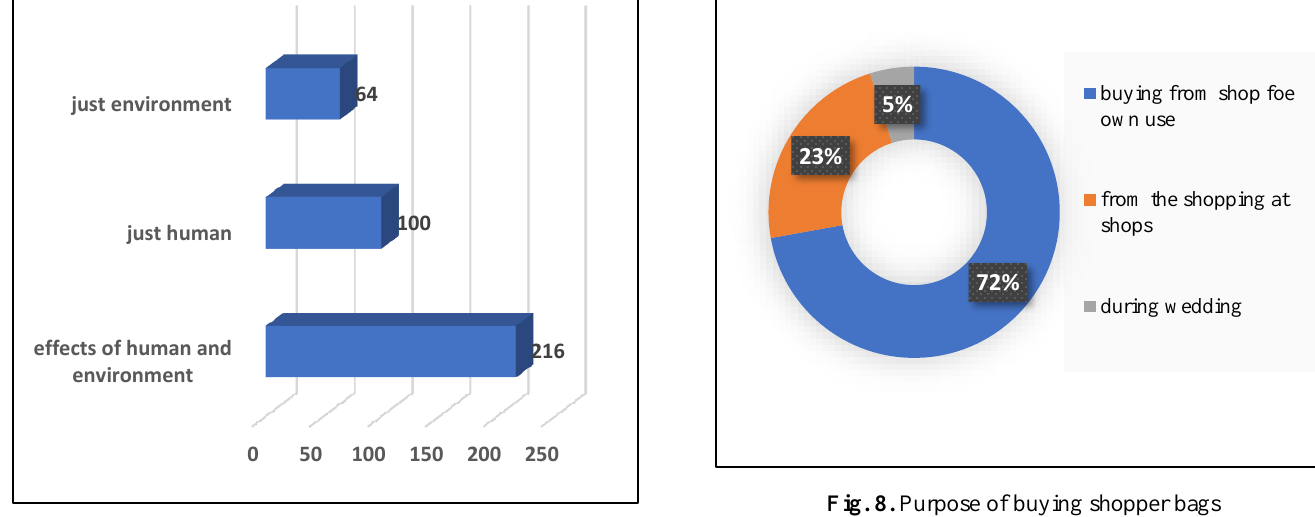
Fig. 6. Effects of plastic waste